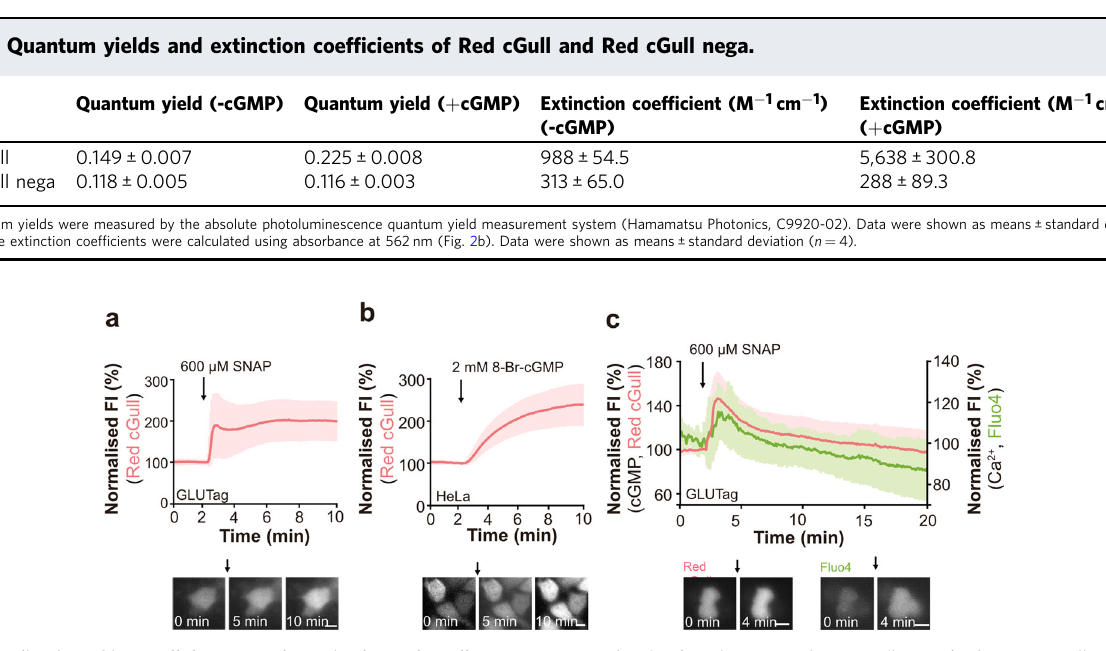
COMMUNICATIONS BIOLOGY| (2022) 5:833